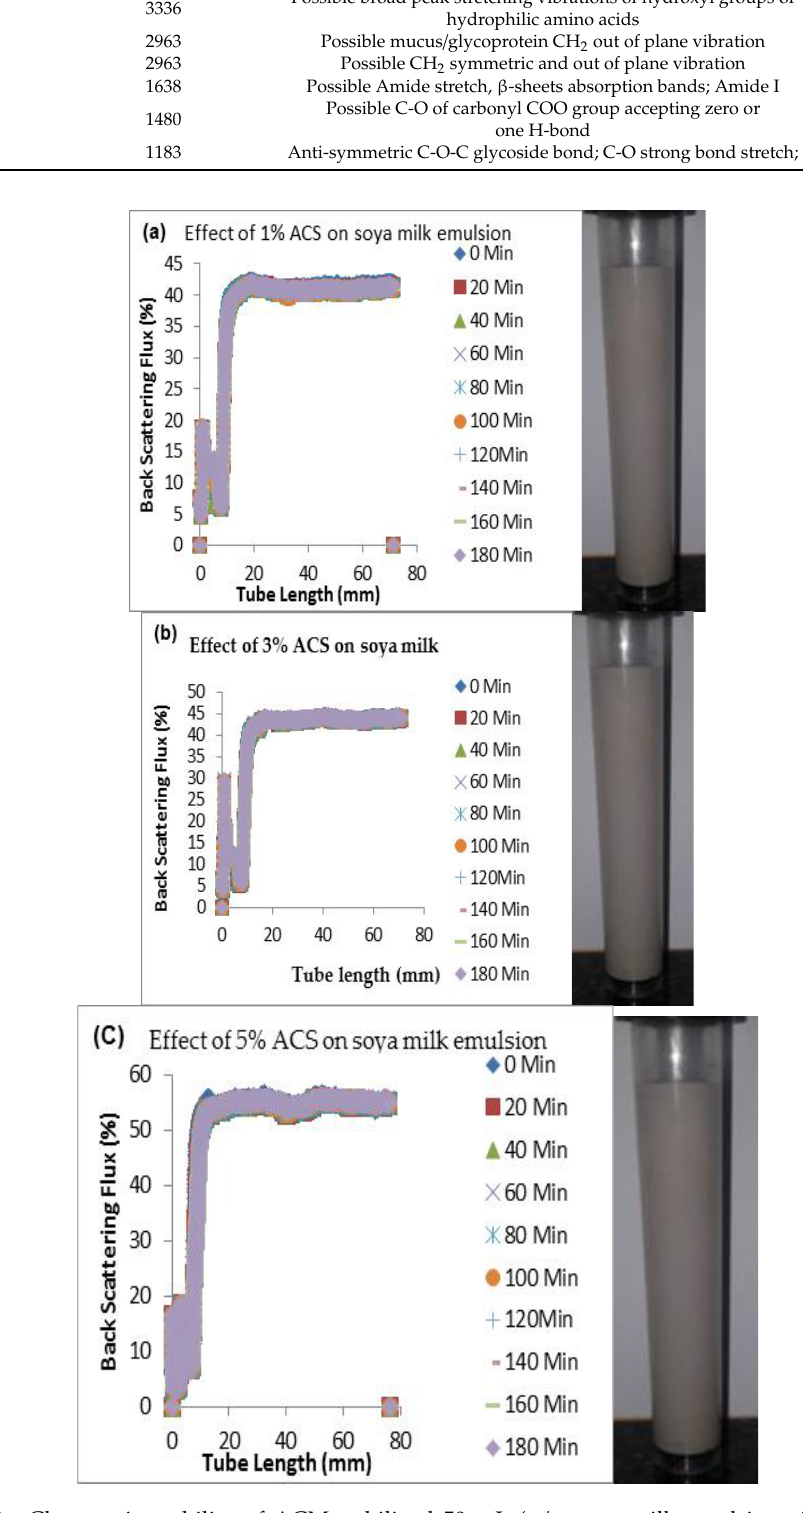
Figure 3. Changes in stability of ACM-stabilized 50 mL ( w / w soya milk emulsions ( a ) 1 g w / w ; ( b ) 3 g w / w ; ( c ) 5 g w / w African catfish mucus. Table 2. Interactions observed in the functional groups ACM-stabilized soya milk emulsion.